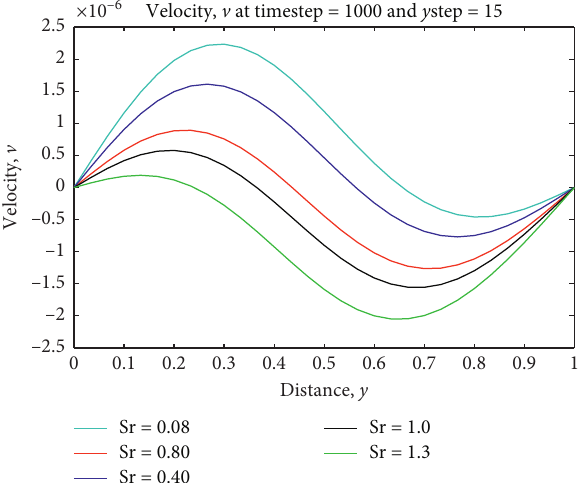
Figure 9: Effects of Soret number on secondary velocity profile.